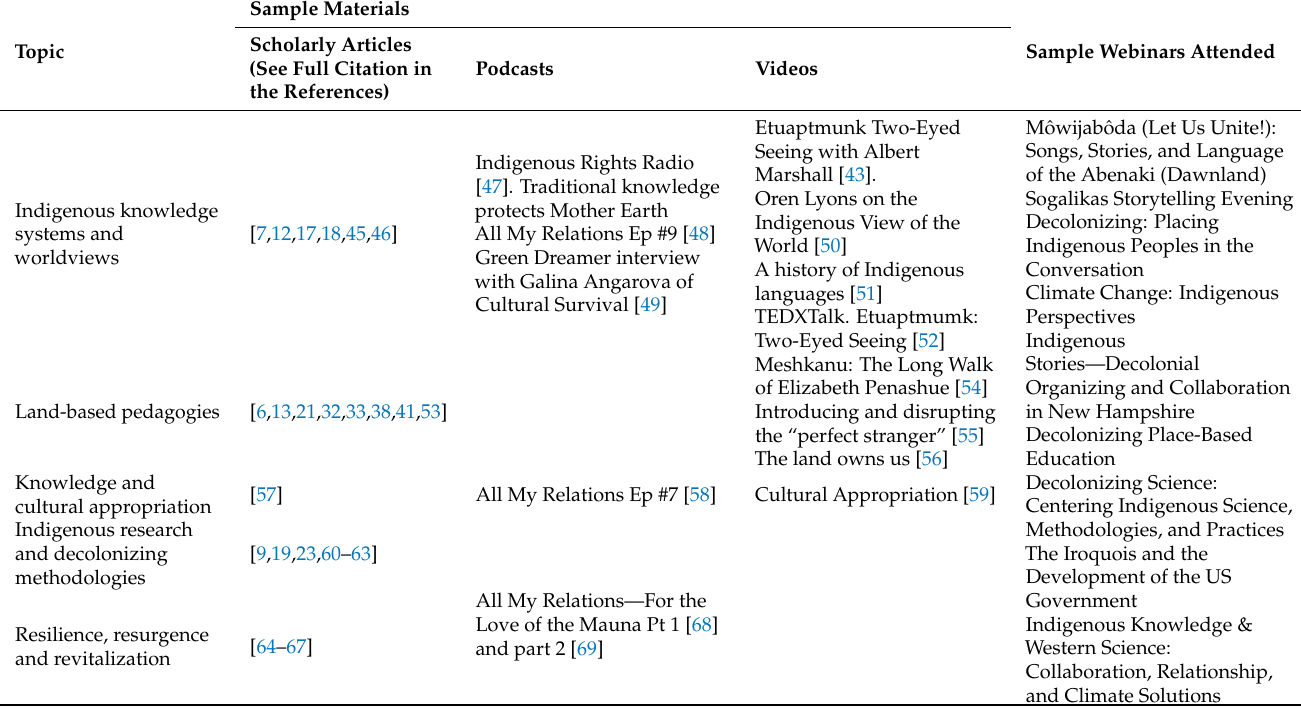
Table 1. Course Content: Topics and